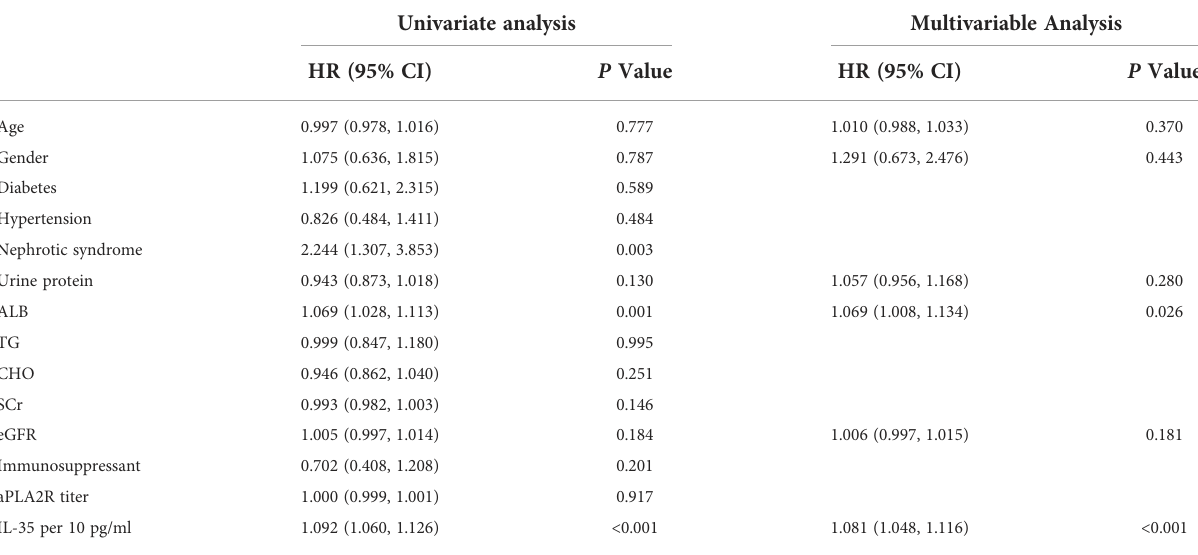
TABLE 2 Cox regression analysis for remission time in IMN patients (IL-35 for continuous variables).